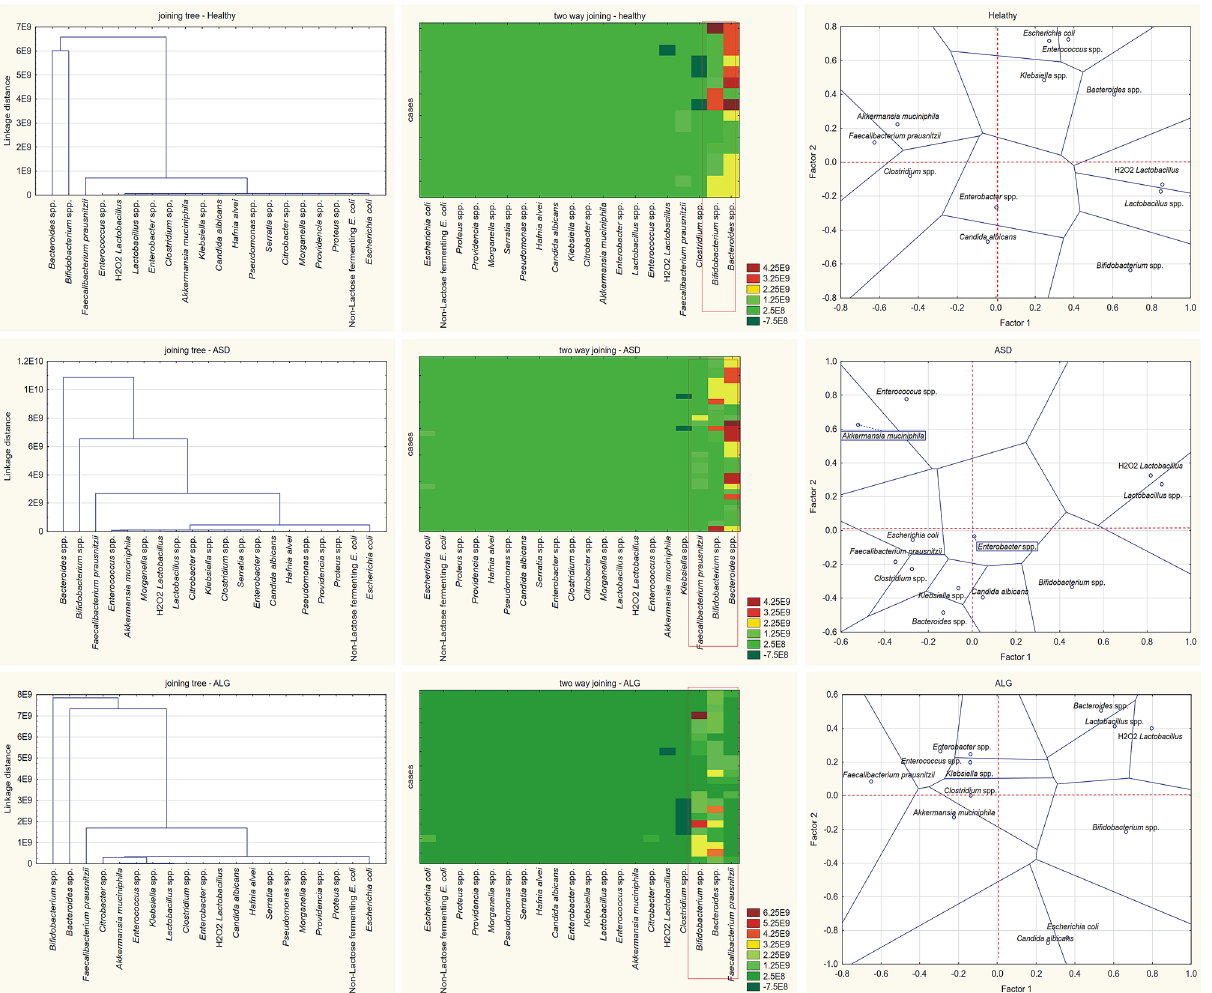
Figure 4. Agglomeration analysis using Euclidian distances, to way joining and correlation matrix for factor analysis of principal components loadings for multi-presence multiple-bacteria